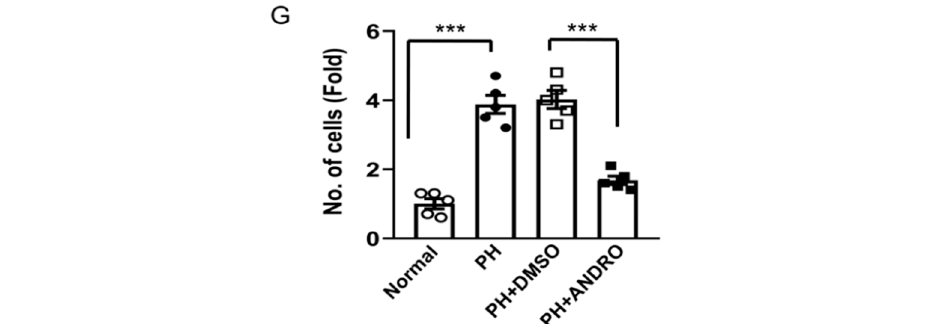
Figure 4. ANDRO reversed the resistance of cells to apoptosis and decreased migration of PH- PASMCs. ( A , B ) Representative TdT-mediated dUTP nick end labeling (TUNEL) assay image ( A ) and group data ( B ) showing that ANDRO reversed apoptosis resistance of PH-PASMCs when compared to the healthy control. ( C ) The dose-dependent effect of ANDRO (1–30 µ M) on cell apoptosis in PH-PASMCs. ( D , E ) ANDRO only increased cell apoptosis at higher concentrations (60 µ M) in healthy PASMCs, both under normal (10% FBS) (D) or serum deprivation (0.1% FBS) (E)conditions. Values are expressed as mean ± SEM, n = 5. ** p < 0.01, *** p < 0.001 vs. normal; ### p < 0.001 vs. PH-DMSO. ( F , G ) Representative images of wound-healing assay ( F ) and group data ( G ) showing that ANDRO (30 µ M, 24 h) significantly reversed cell migration in PH-PASMCs. n = 5. Data are shown as mean ± SEM. *** p <